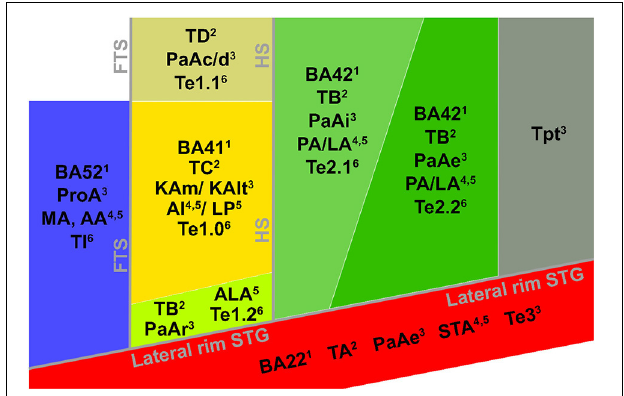
FIGURE 2 | Cytoarchitectonic characterization of human auditory cortex. Major landmarks are outlined and named in gray. The layout and combinations are interpreted from Brodmann (1909) 1 , Von Economo and Horn (1930) 2 , Galaburda and Sanides (1980) 3 , Rivier and Clarke (1997) 4 , Wallace et al. (2002) 5 , Morosan et al. (2001, 2005) 6 , and Clarke and Morosan (2012) 6